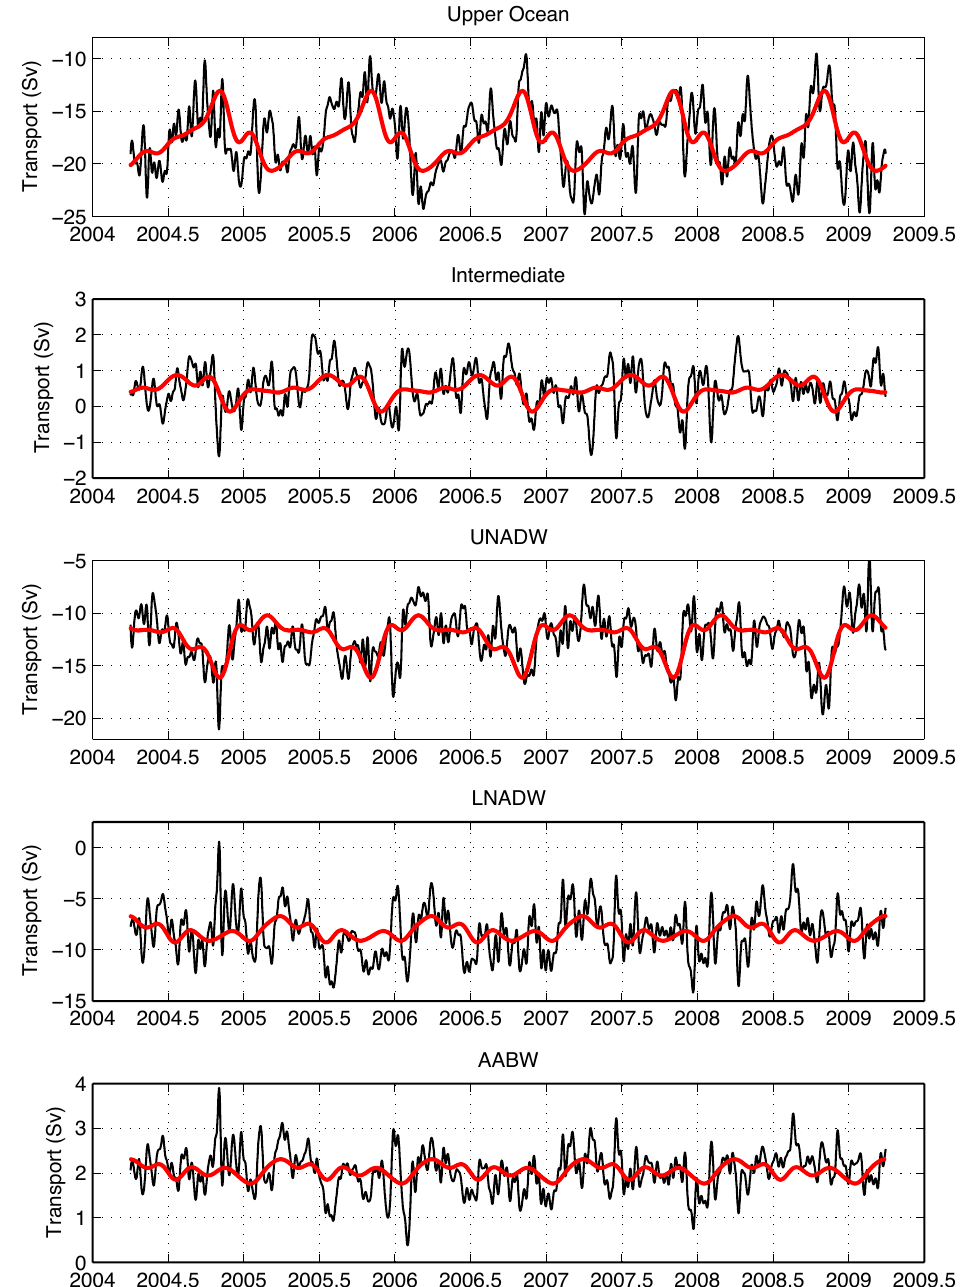
Fig. 7. April 2004–April 2009 Rapid-WATCH transport timeseries at 26.5 ◦ N (black) with the mean seasonal cycle overlaid (red). Mid- ocean timeseries are calculated using time-mean Ekman and Florida Straits transports (to isolate mid-ocean variability). Seasonal cycles are calculated from the 5-year mean of each twice daily value (i.e., all 1 January’s, all 2 January’s, etc.) which are then 60-day low-pass filtered to obtain the seasonal